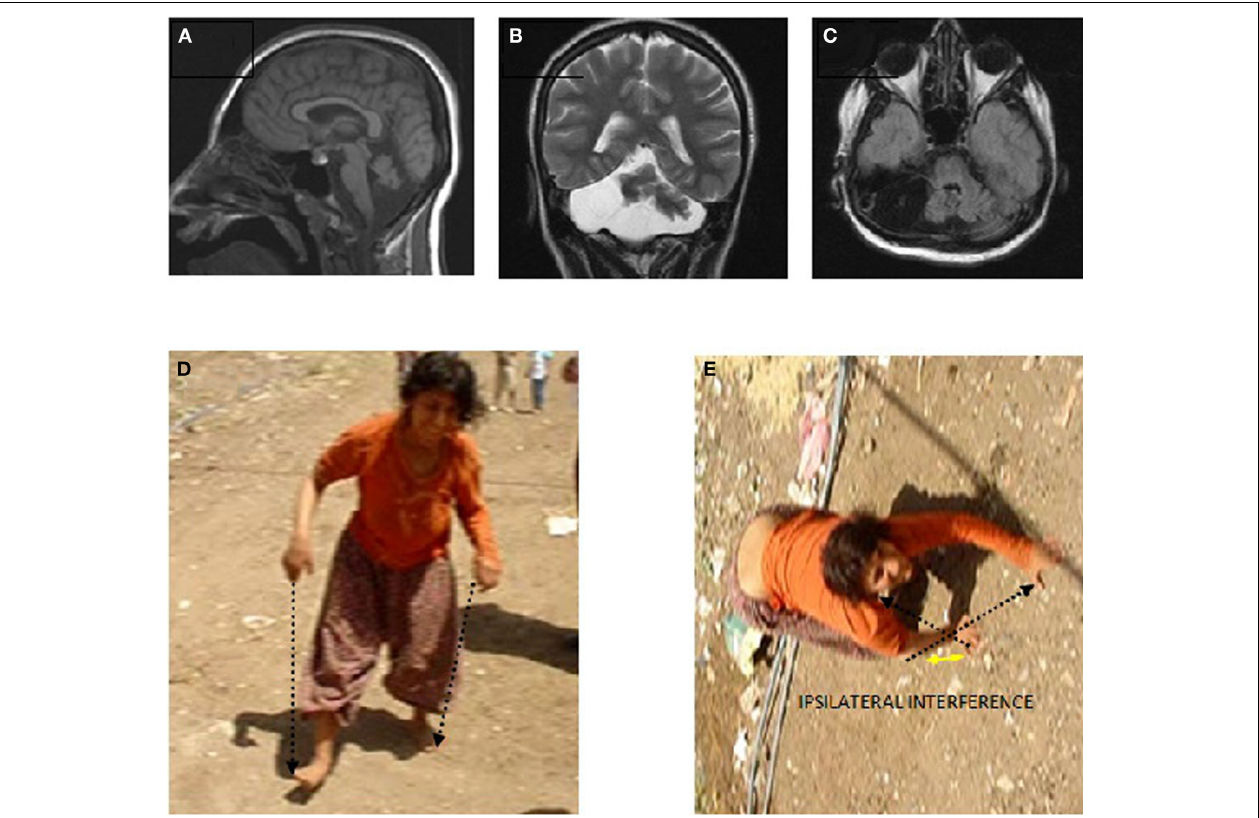
FIGURE 6 | Case IV-23. Sagittal (A), coronal (B), and axial (C) MRI scans. (D) Parallel-sequence ataxic BL: right arm-right leg and left arm-left leg (see arrows); (E) diagonal-sequence QL: left arm-right leg and right arm-left leg (see arrows).